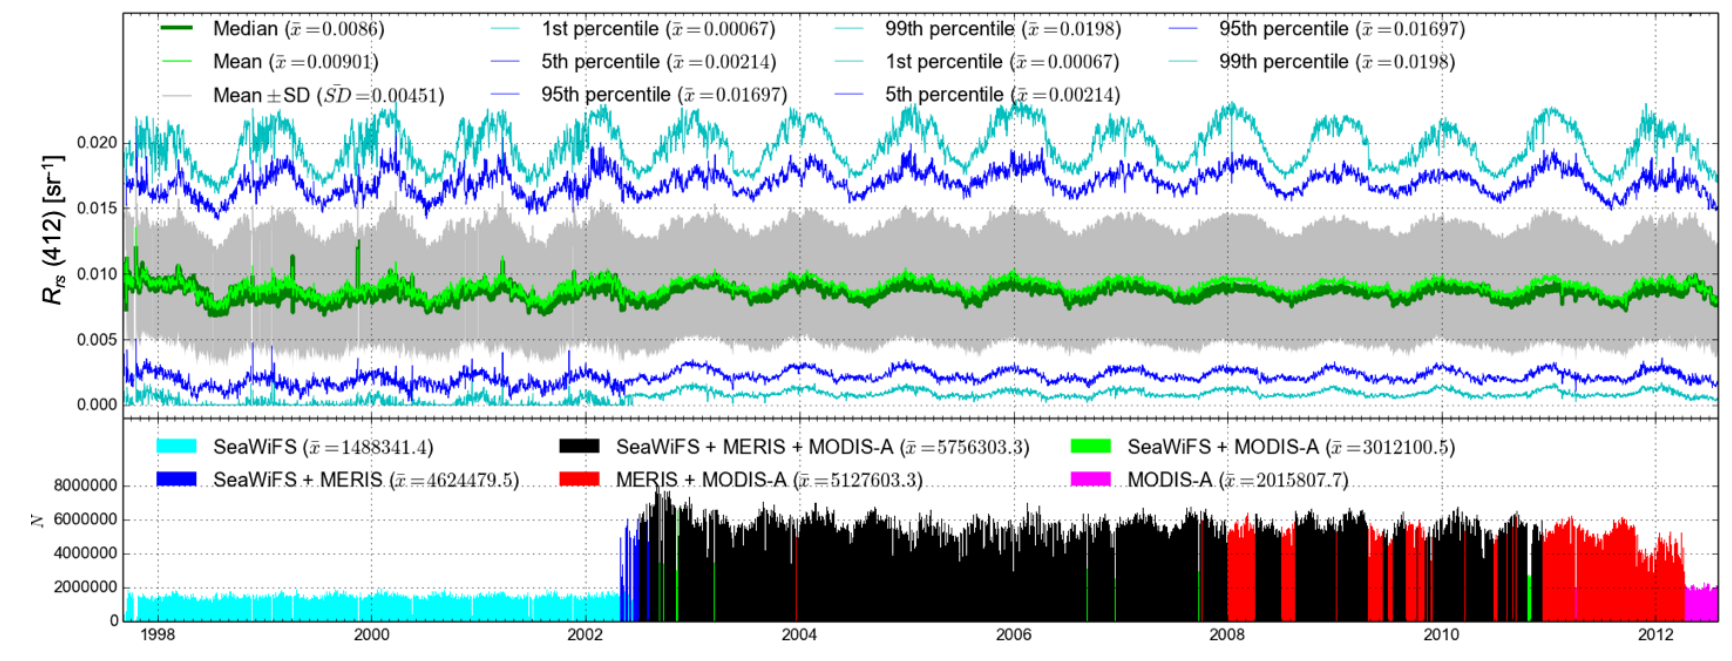
Figure 2. Top panel: Time-series values of global average R rs (412) [sr − 1 ] and associated statistics ( ± one standard deviation; 1, 5, 95, and 99 percentiles for v1 dataset). Bottom panel: Number or pixels with valid data on a daily basis from 1997 third quarter to end of 2012. The colour code indicates the combination of sensors (SeaWiFS, MERIS, and MODIS-Aqua) contributing to the data stream. Note that the number of observations available per pixel more than triples on average, when MODIS-Aqua and MERIS data are added to SeaWiFS